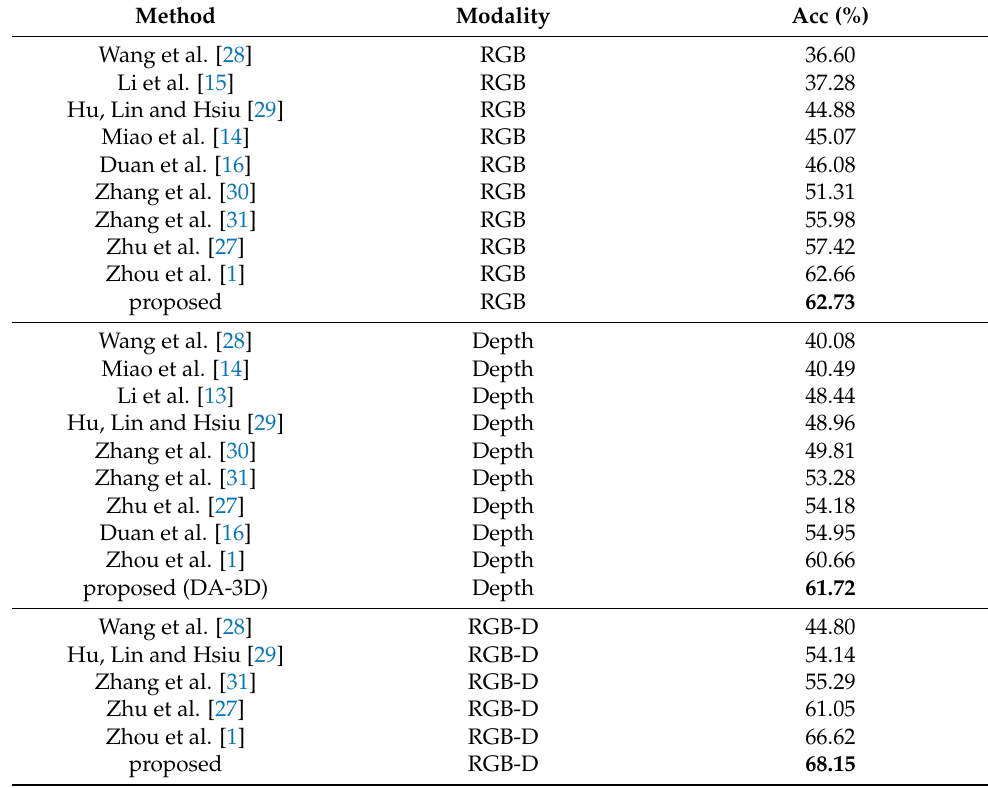
Table 1. Comparison with state-of-the-art methods on IsoGD.